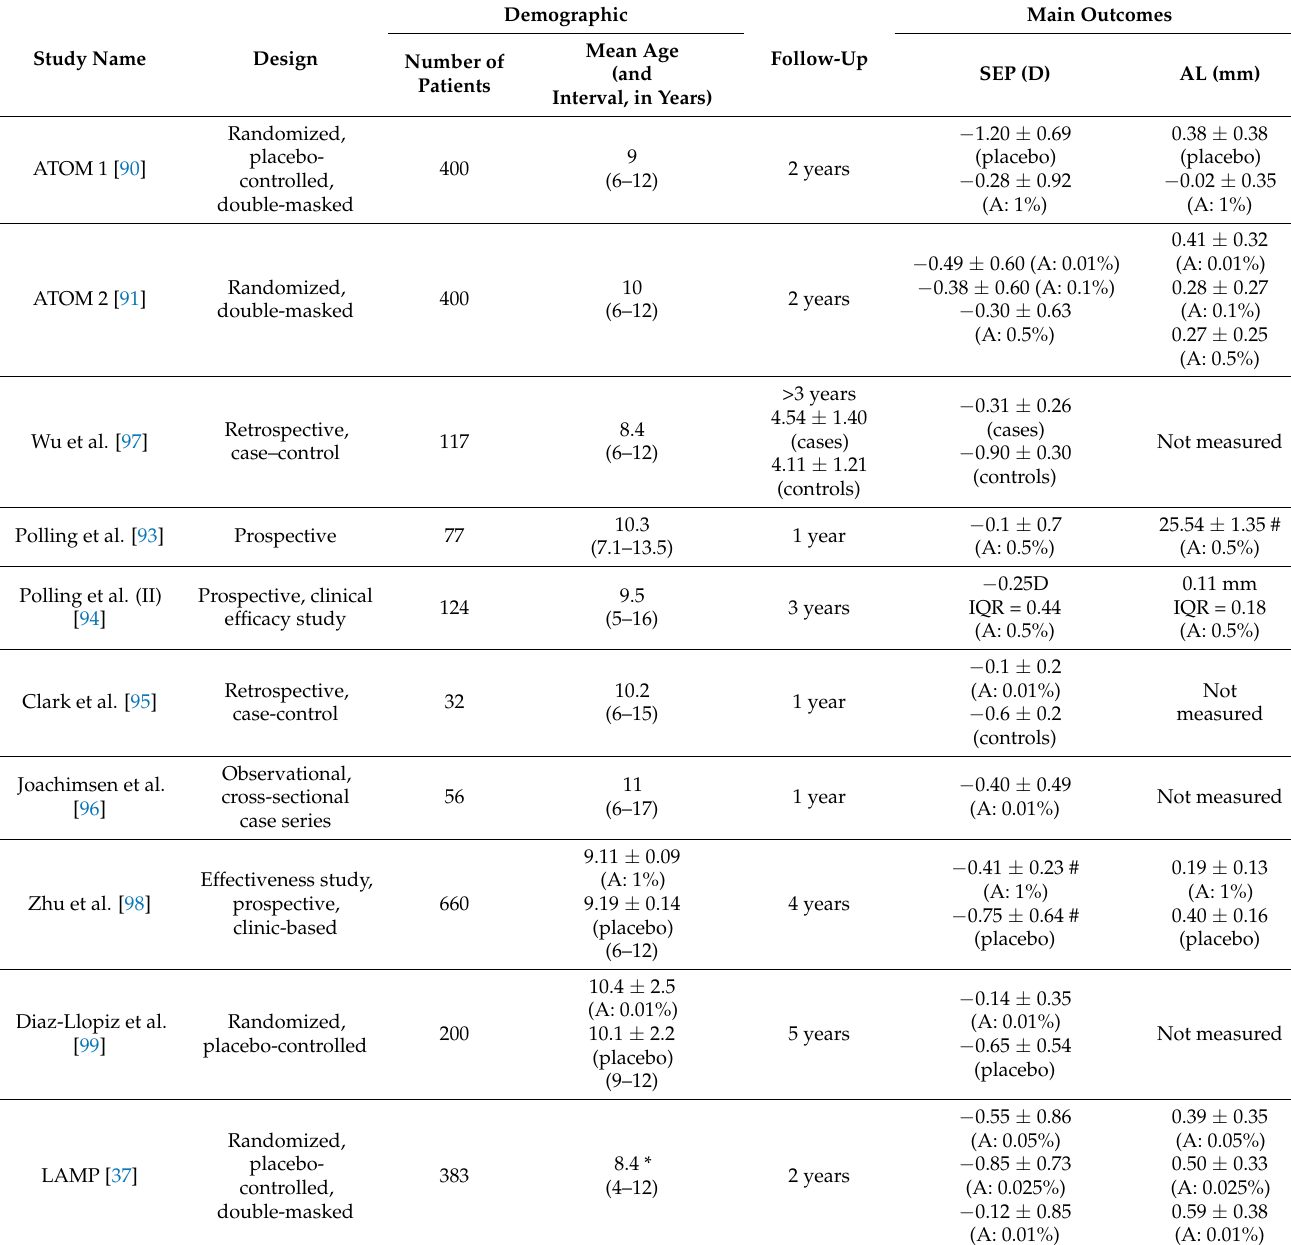
Table 1. Clinical trials on the efficacy of atropine in controlling myopia